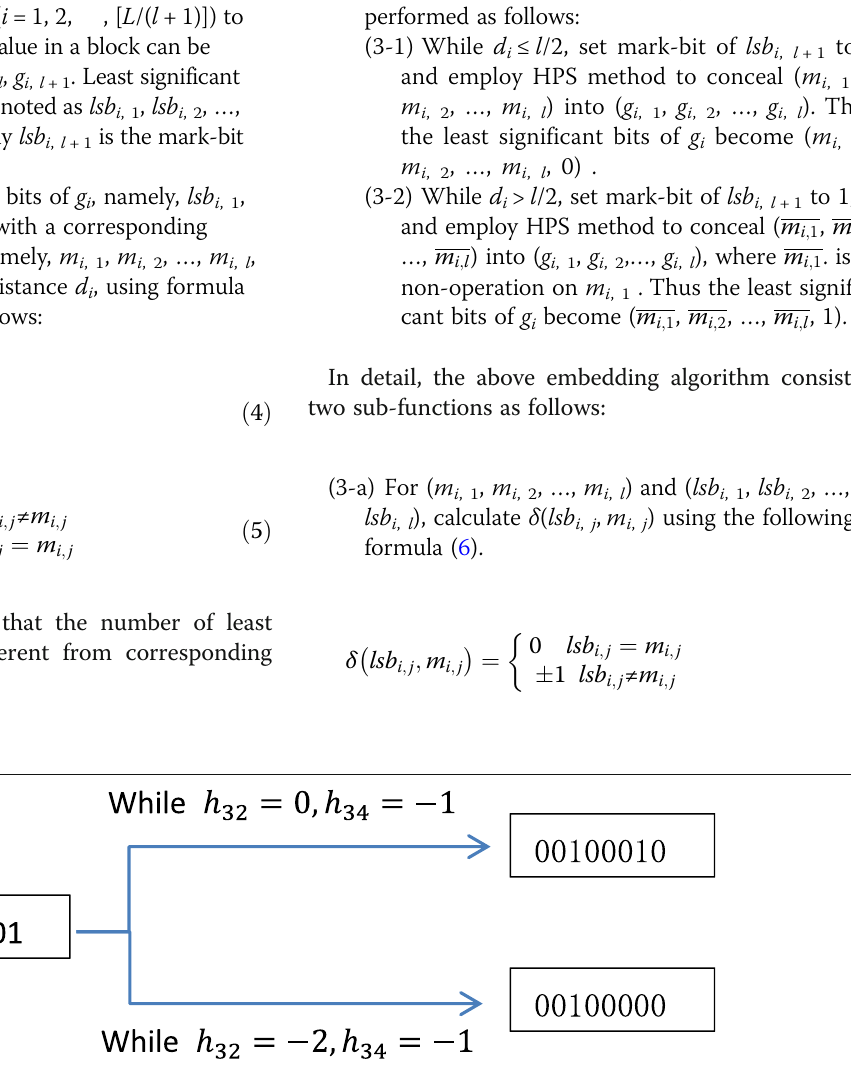
Fig. 6 Assume g i, j is 00100001. Embed 0 into g i,